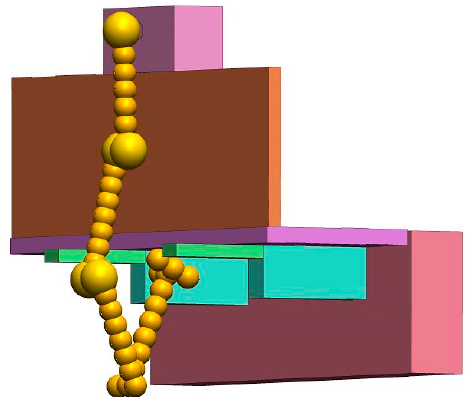
Figure 12. Manipulator and railway bridges simplified as spheres and cuboids.